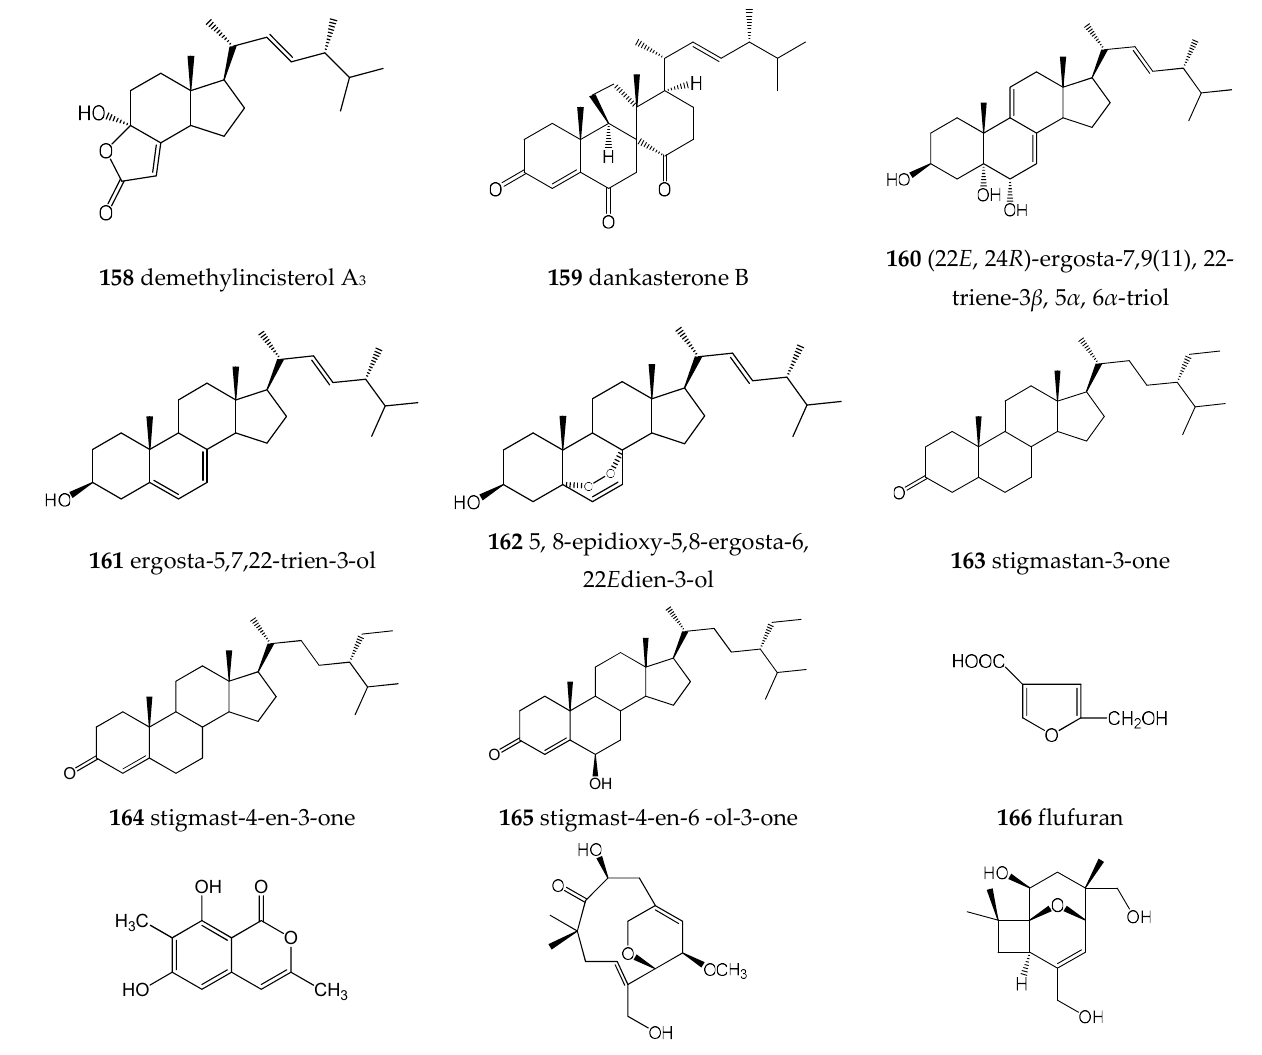
From Chinese mangrove Rhizophora mucronata , an endophytic Pestalotiopsis sp. was isolated, and 11 known compounds were identified, which were not introduced by Yang XL et al. [21] and Xu J et al. [10], including demethylincisterol A 3 ( 158 ), dankasterone B